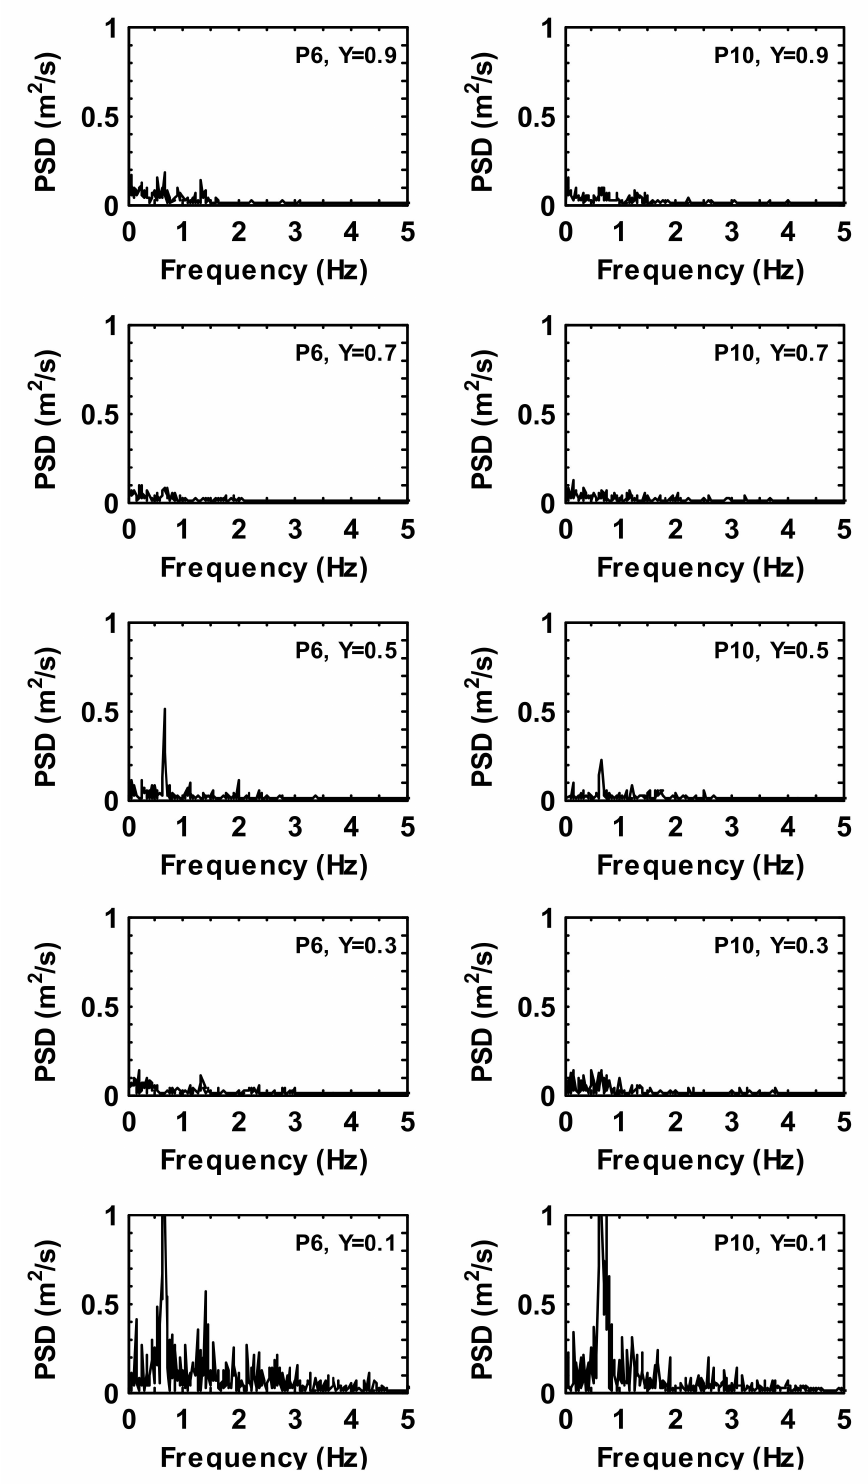
Figure 13. Power spectra density of the time history velocity magnitude fluctuations at monitoring locations P 6, P 10 for case